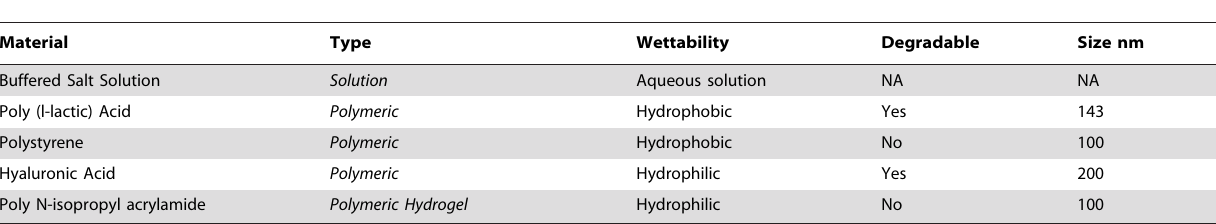
Table 1. Physical properties of nanoparticles used for intravitreous implantation.